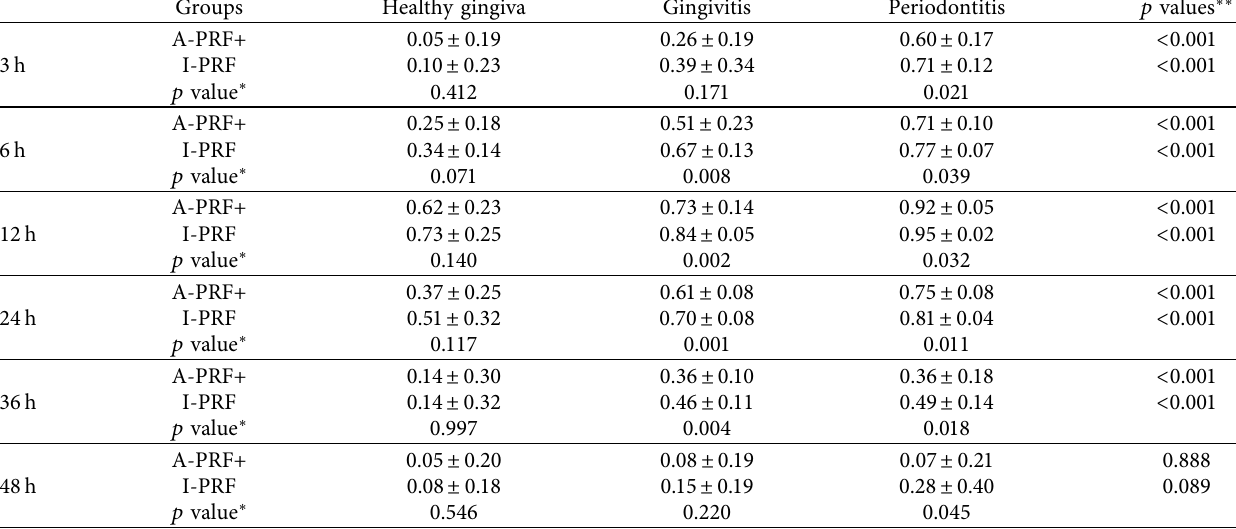
Table 4: Time-kill kinetics assay: the percent reduction in the number of bacterial colonies compared to the control under the infuence of diferent blood-derived products (A-PRF+ and I-PRF) from the three groups at 3, 6, 12, 24, 36, and 48h. Groups